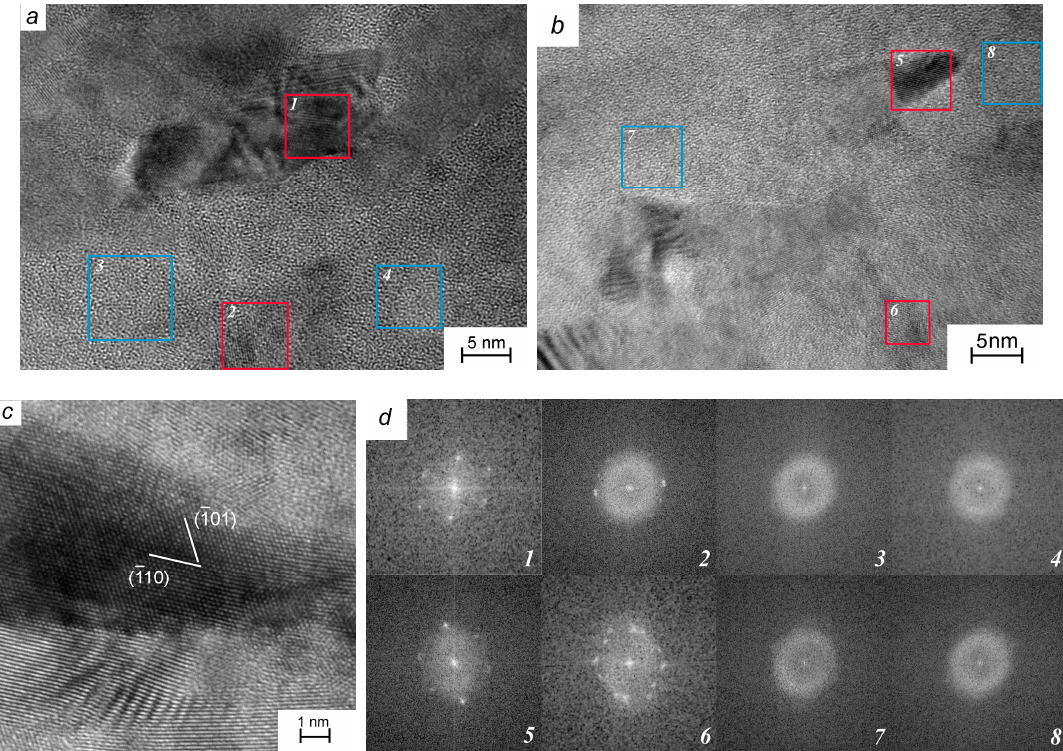
Figure 13. HR TEM images of the structure of Cu-Nb nanolaminate after HPT to N = 4 ( a,b,c ) and fast Fourier transform (FFT) diffractograms ( d ) of the outlined areas 1 – 8 of ( a ),( b ), respectively.